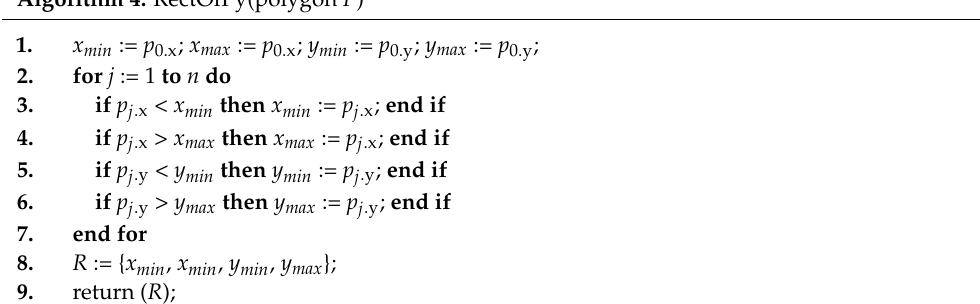
Algorithm 4. RectOfPy(polygon P